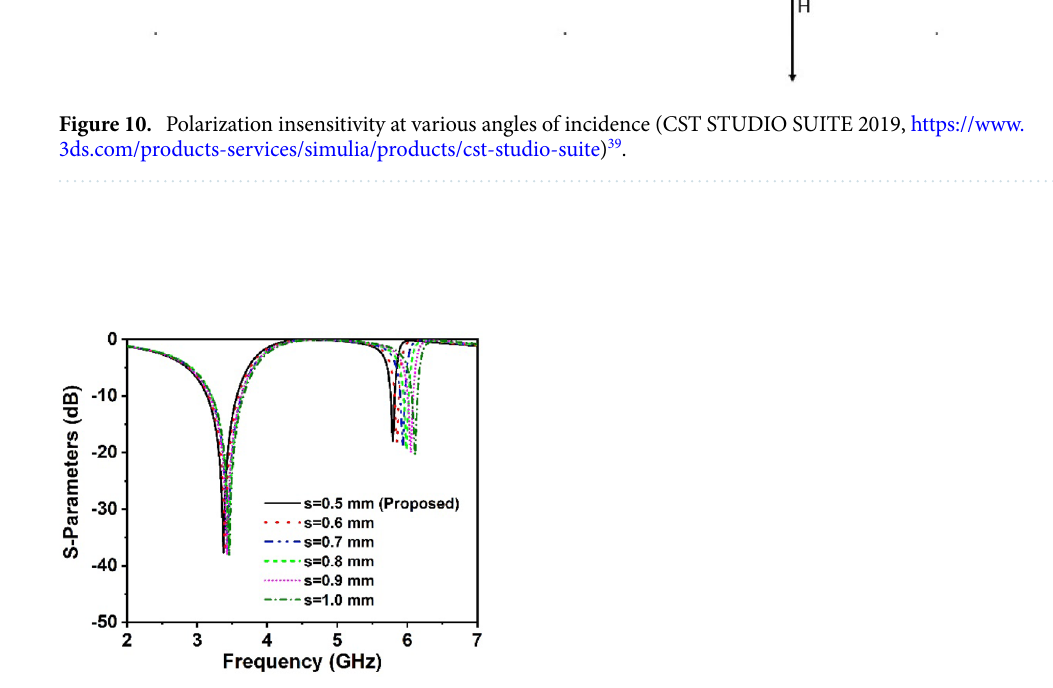
Figure 11. Comparison representations for various split gaps of the proposed